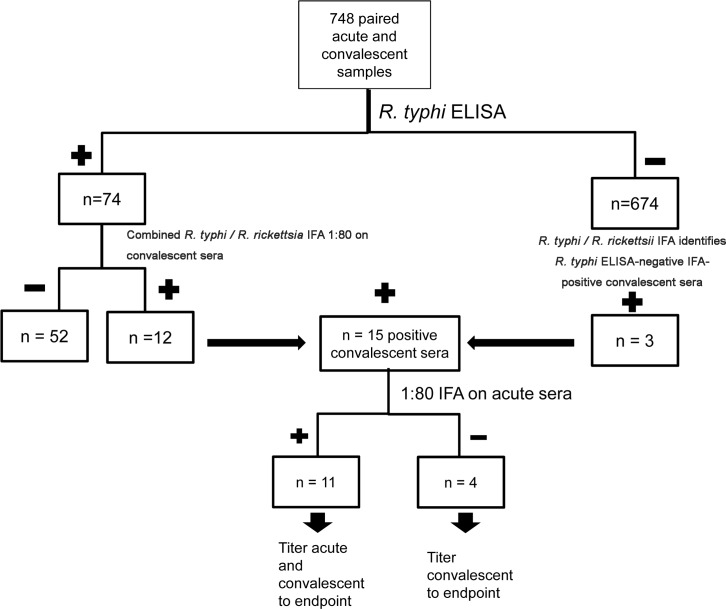
Flow diagram depicting approach to serological evaluation of convalescent and acute phase sera for IgG antibodies to R. typhi, including ELISA and IFA.Note that the IFA substrate slides used resulted in simultaneous tests for both R. rickettsii and R. typhi; those samples identified with R. rickettsii IFA antibodies were then included in the R. rickettsii tally (Fig 1) if not R. rickettsii ELISA reactive.